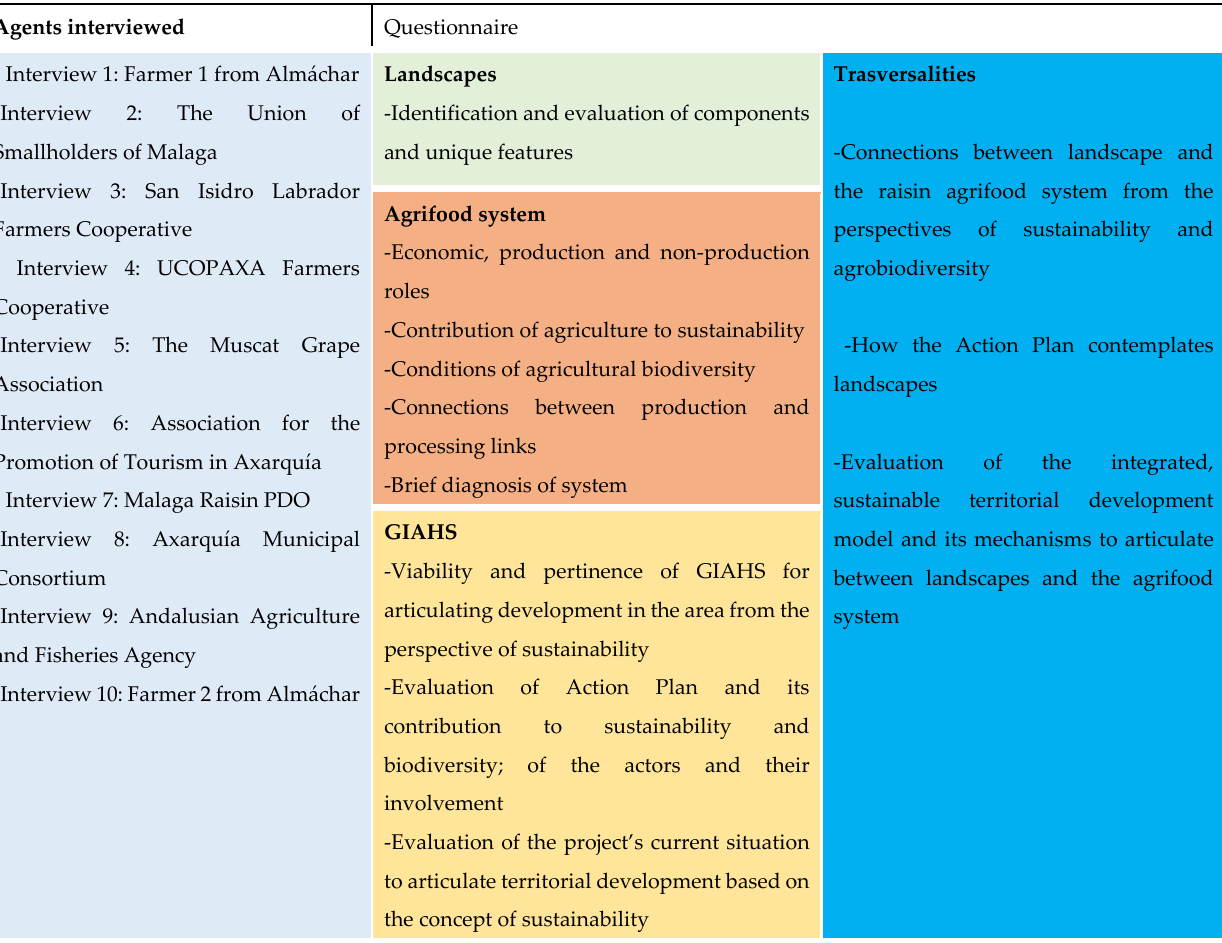
Figure 2. Interview methodology: agents and questionnaire. Source: Prepared by authors.